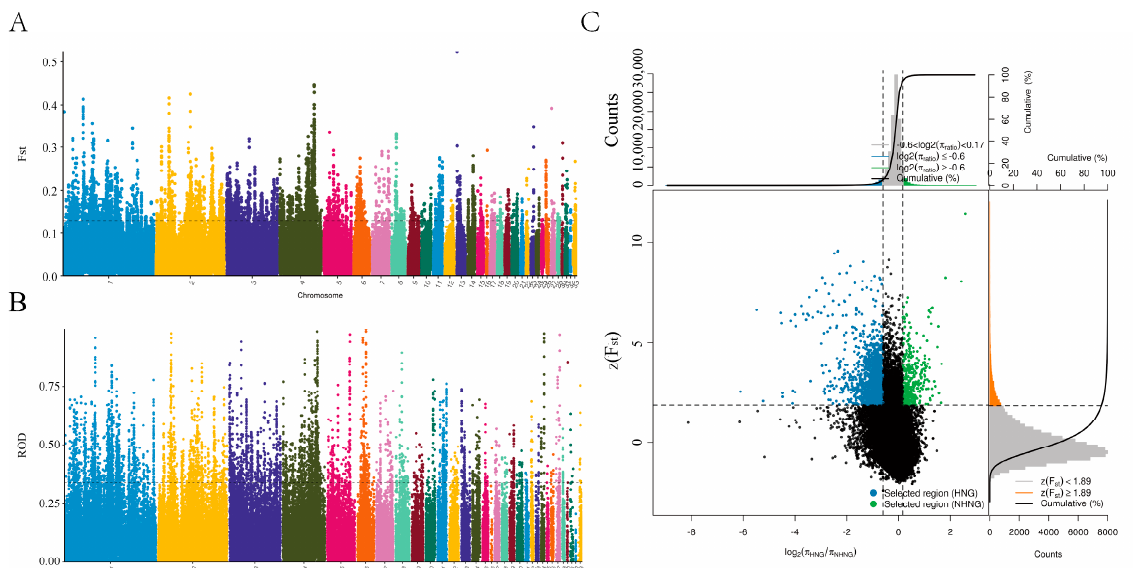
Figure 4. Whole genome scanning of the selection signatures between HNG and NHNG chickens. Selection signals distribution of ( A ) FST, ( B ) ROD calculated for 40 kb windows sliding in 10 kb steps. ( C ) Signals intersection by FST and ROD. Blue points represent (HNG selected genomic regions with both an extremely high Z (FST) value (top 5% level) and ROD value (top 5% level).